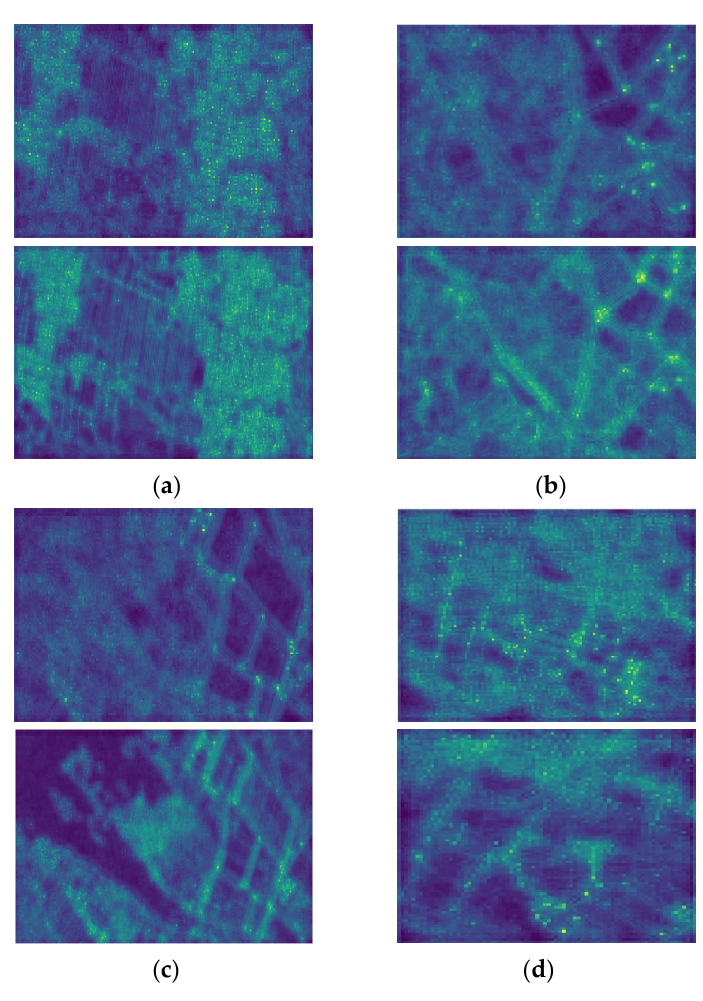
Figure 7. Visualization of feature maps: ( a ) image pair a, ( b ) image pair b, ( c ) image pair c, and ( d ) image pair d.